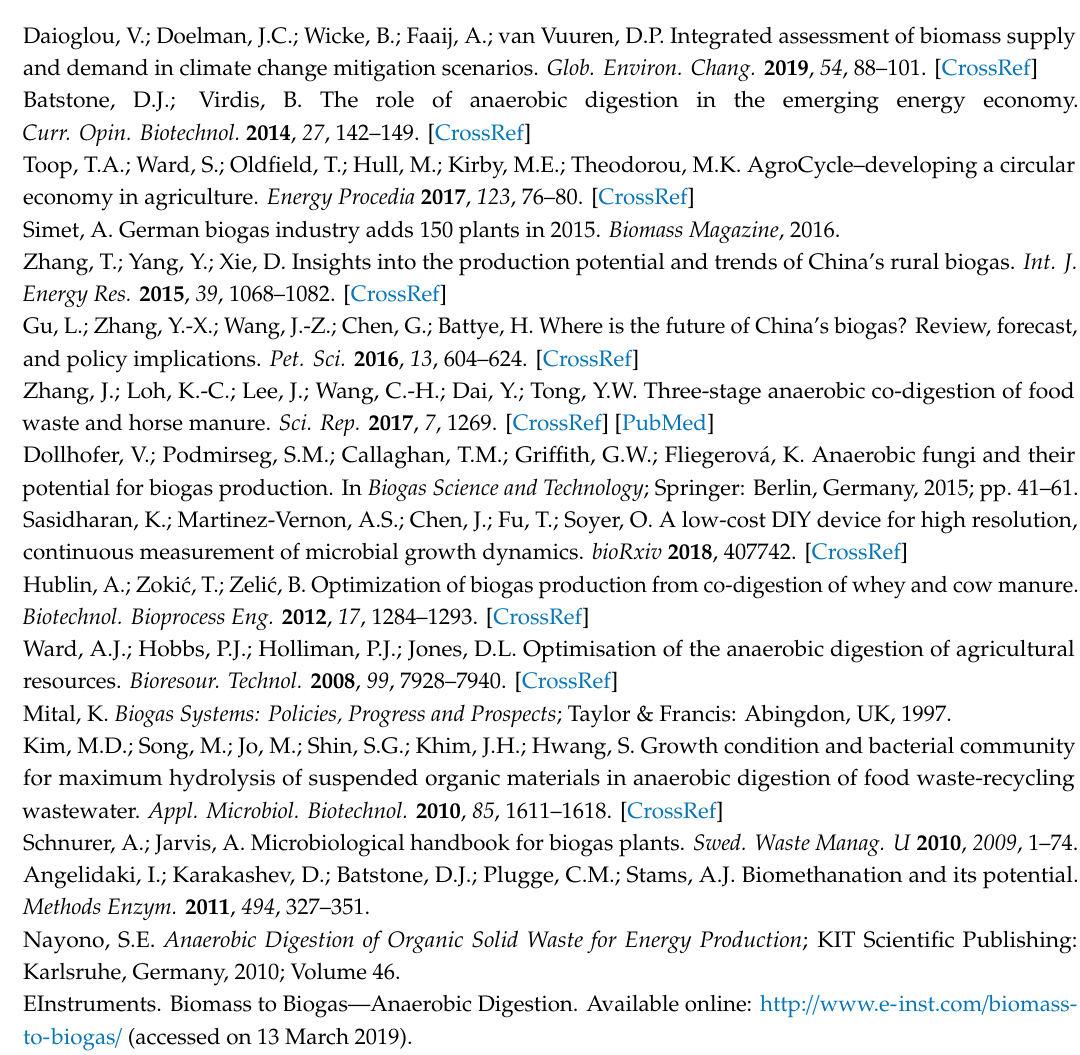
Figure S1: Artwork Figures Revised, Table S1: Table Artwork Tables